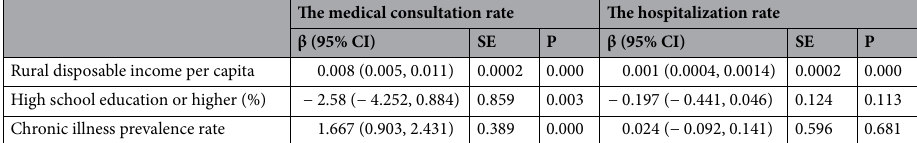
Table 2. Associations between rural disposable income per capita, education levels, the chronic illness prevalence rate and the medical consultation rate/hospitalization rate.